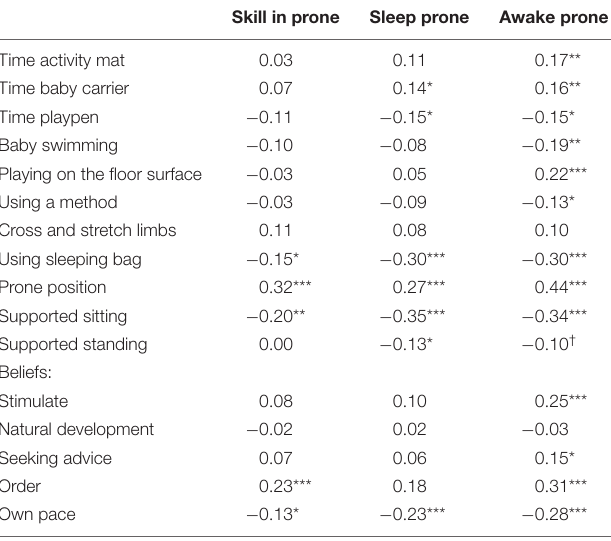
TABLE 6 | Partial correlations controlling for child’s age, between practices, beliefs, and motor